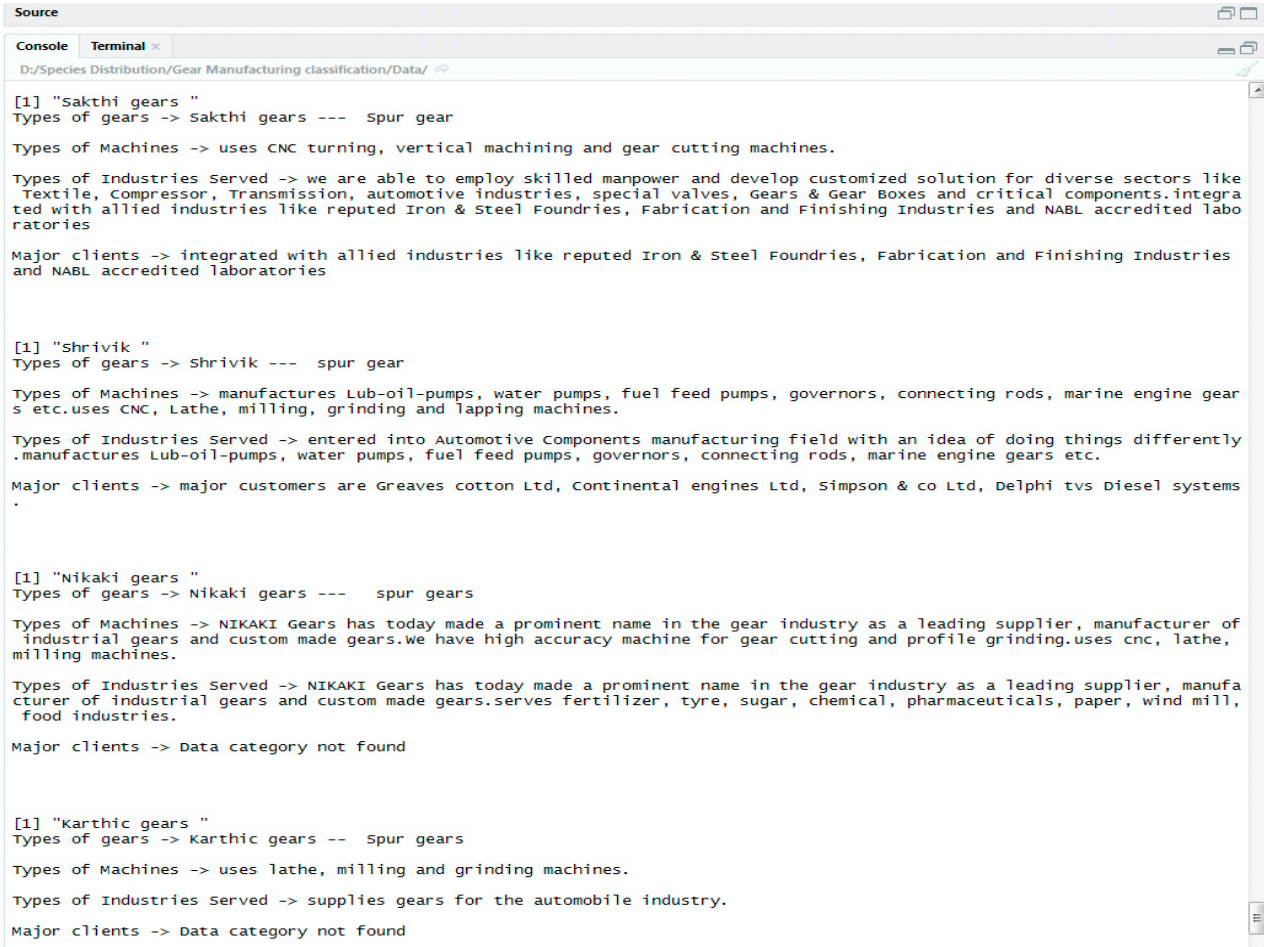
Figure 6. Screen shot of extracted enterprise information and classification into task-specific supplier with text mining.